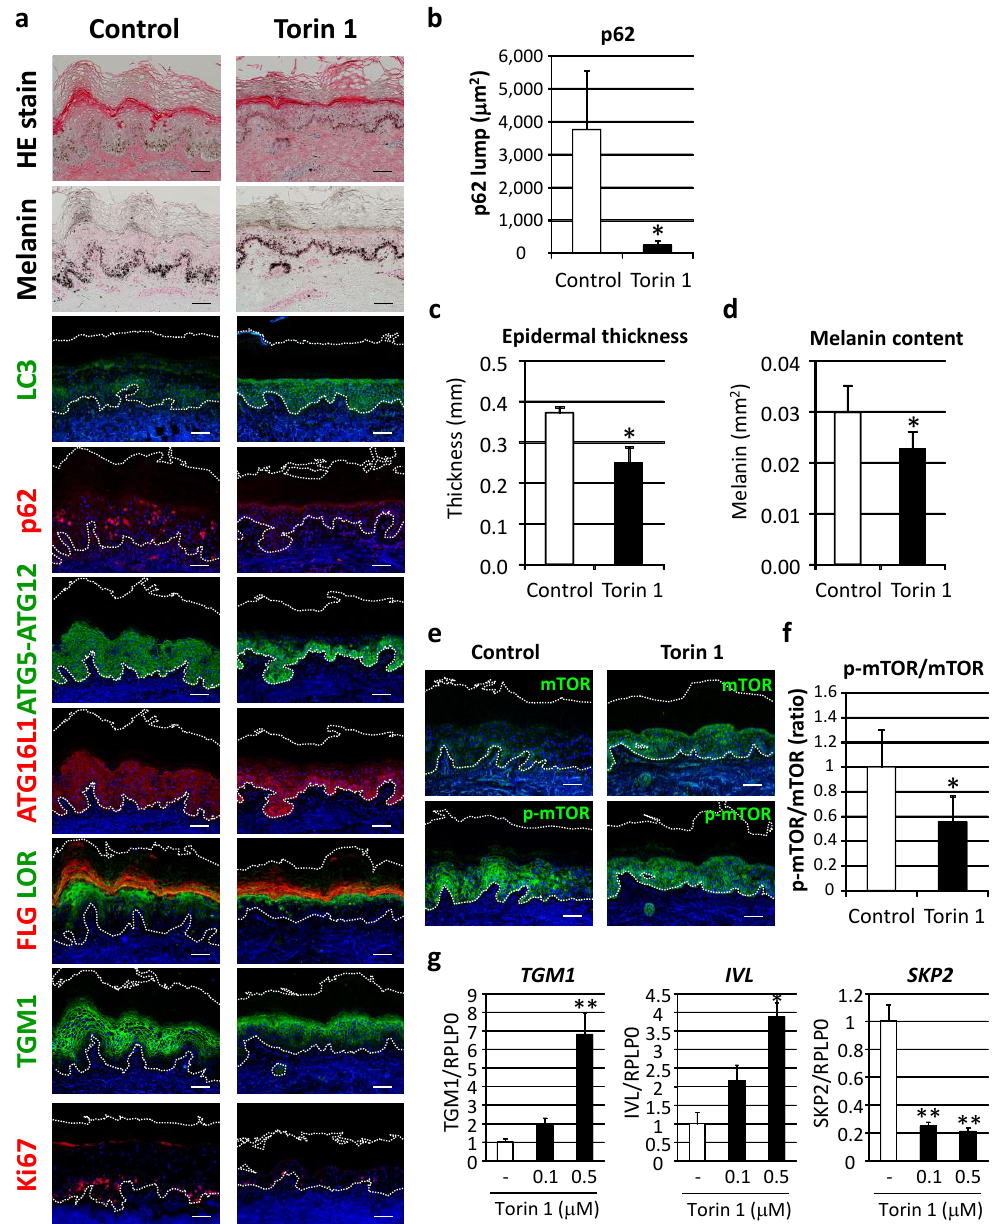
台紙 2.36 × 3.16 cm Figure 7. Inhibition of mTORC1 improved hyperpigmentation through restoration of autophagy. ( a ) Tissues obtained from AA elbow samples were treated with or without 1 µ M Torin 1 for five days. Skin tissues cultured ex vivo were then subjected to hematoxylin and eosin (HE), and Fontana-Masson melanin staining for immunofluorescent analyses of LC3 (green), p62 (red), ATG5-ATG12 (green), ATG16L1 (red), FLG (red) and LOR (green) together, TGM1 (green), and Ki67 (red). Merged images with DAPI nuclear staining are shown. Bars = 100 μm. ( b ) Stained areas of aggregated p62 protein lumps were measured using the Image J software package. Values for the total areas of the p62 lumps are expressed as the mean ± SD ( n = 4). * p < 0.05 (paired t-test). ( c ) Tissues with Fontana-Masson staining were subjected to Image J analysis to determine the thickness of the whole epidermis. Values are shown as the mean ± SD ( n = 4). * p < 0.05 (paired t-test). ( d ) Relative areas positive for melanin per the length of stratum corneum were analyzed. Values show means ± SD ( n = 4). * p < 0.05 (paired t-test). ( e ) Immunofluorescent analysis (green, top panels) and phosphorylation (green, bottom panels) of mTOR (p-mTOR) were performed after subjecting to nuclear staining with DAPI. Bars = 100 µ m. ( f ) Fluorescent intensity was quantified and normalized based on the length of the basement membrane (BM). The ratio of p-mTOR and mTOR was compared between Torin 1-treated and -untreated